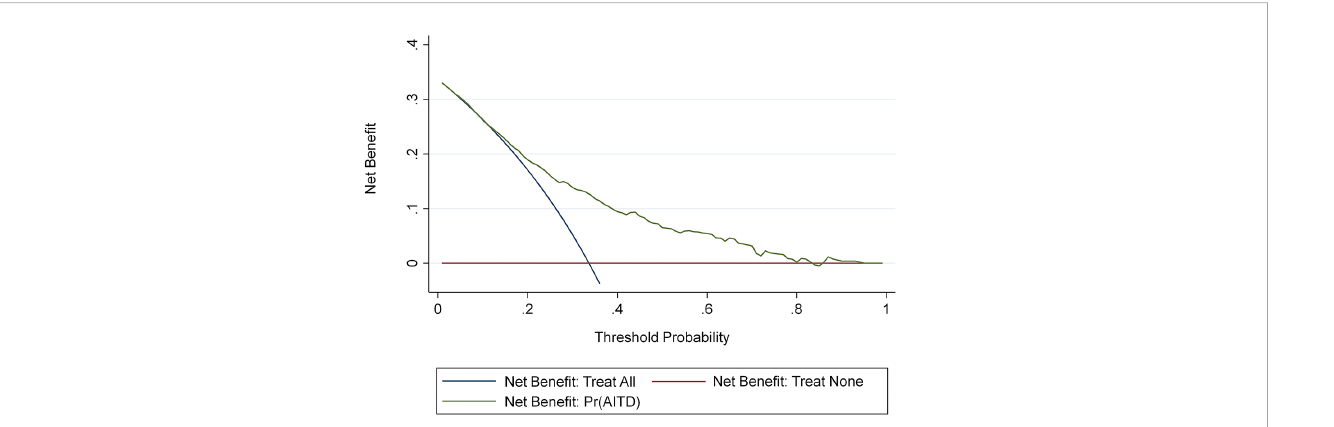
FIGURE 6 The AITD decision curve to assess the risk of meaning map. The y-axis represents net income. The blue line represents the risk nomogram of AITD. The thin solid line represents the hypothesis that all patients have AITD. The thick solid line represents the hypothesis that no patients have